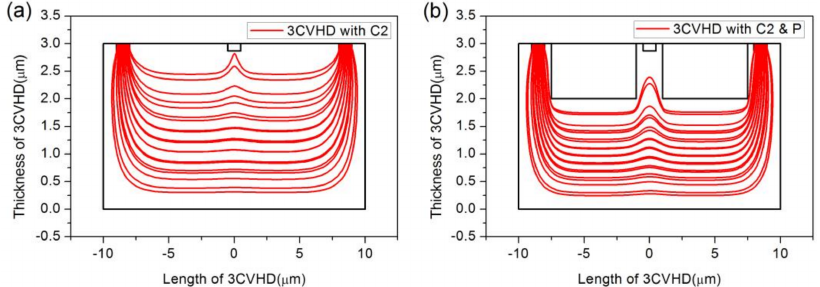
Figure 8. Comparisons in the distribution of current density. ( a ) Sensor with C2. ( b ) Sensor with C2 and P-type layers. The device is 3 µ m deep and P-type layers are 1 µ m